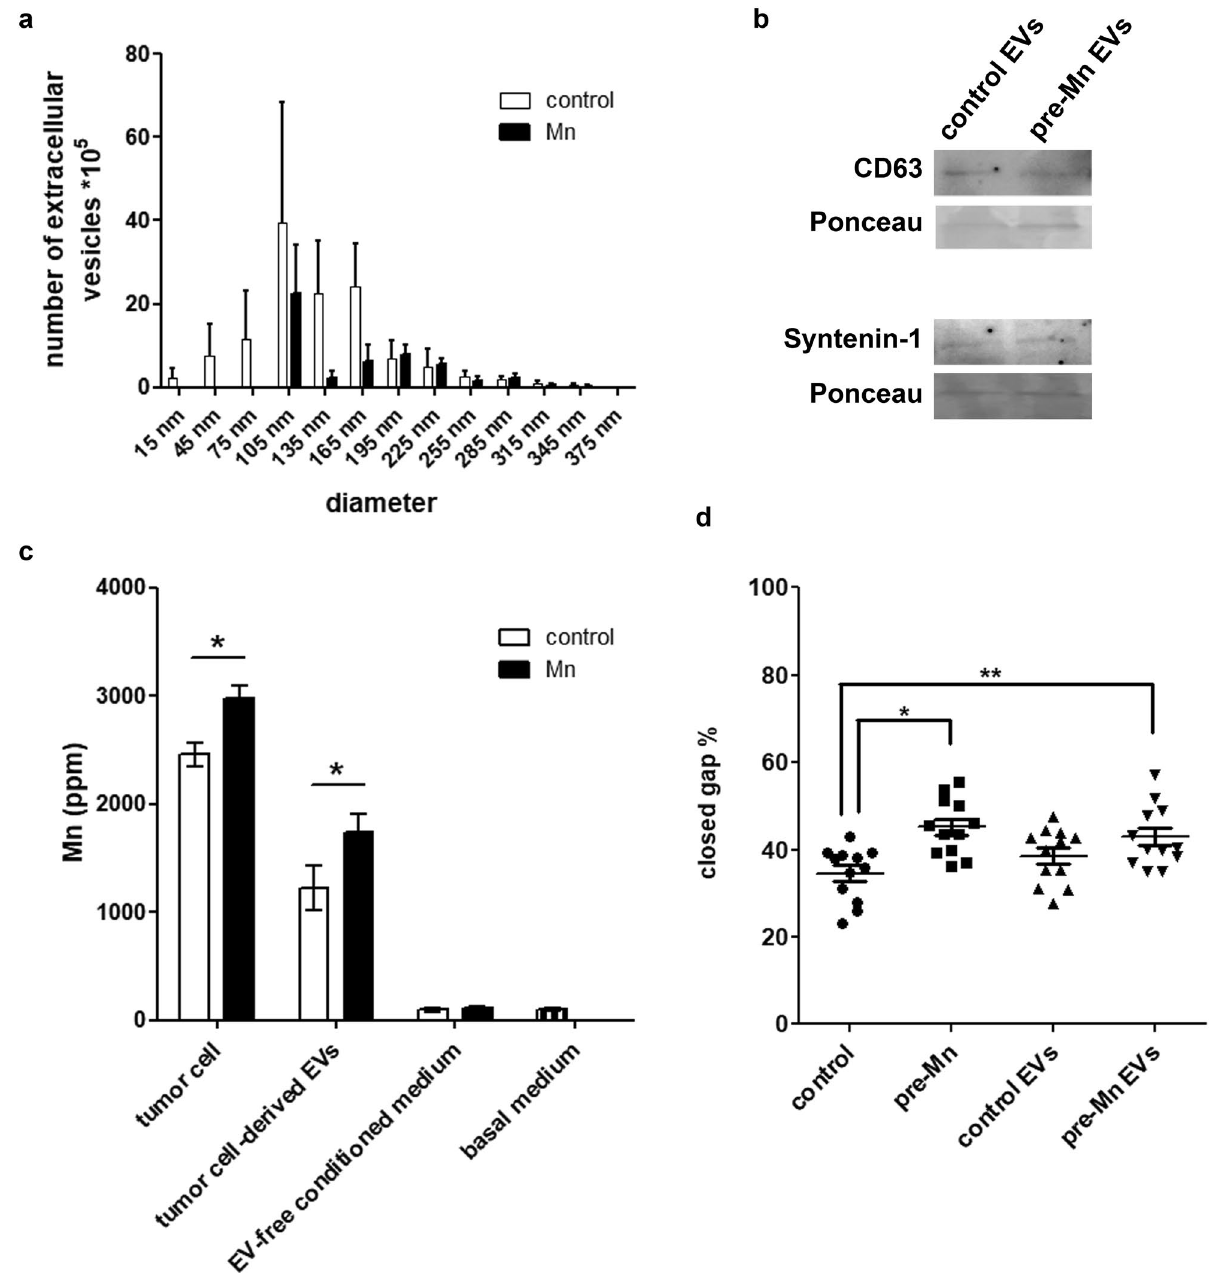
Figure 6. Tumor cell-derived extracellular vesicles are enriched in manganese and affect tumor cell migration. LLC cells-derived extracellular vesicles were concentrated by ultracentrifugation. ( a ) EVs quantification and size determination. N = 6. ( b ) CD63 and syntenin-1 detection by Western blotting. Ponceau was used as total protein control. ( c ) Tumor cells, EV-enriched fraction, EV-free conditioned medium and basal medium were analyzed by X-Ray Fluorescence. N = 6. Units are expressed in concentration as ppm (parts per million). Control cells— white bars; Mn-pretreated cells (Mn) – black bars. *p < 0.05, Student’s T test. ( d ) Wound healing assays of LLC cells incubated with extracellular vesicle-enriched medium from control and Mn-pretreated LLC cells. N = 12. *p < 0.05; **p < 0.01, one-way ANOVA and Bonferroni’s Multiple Comparison